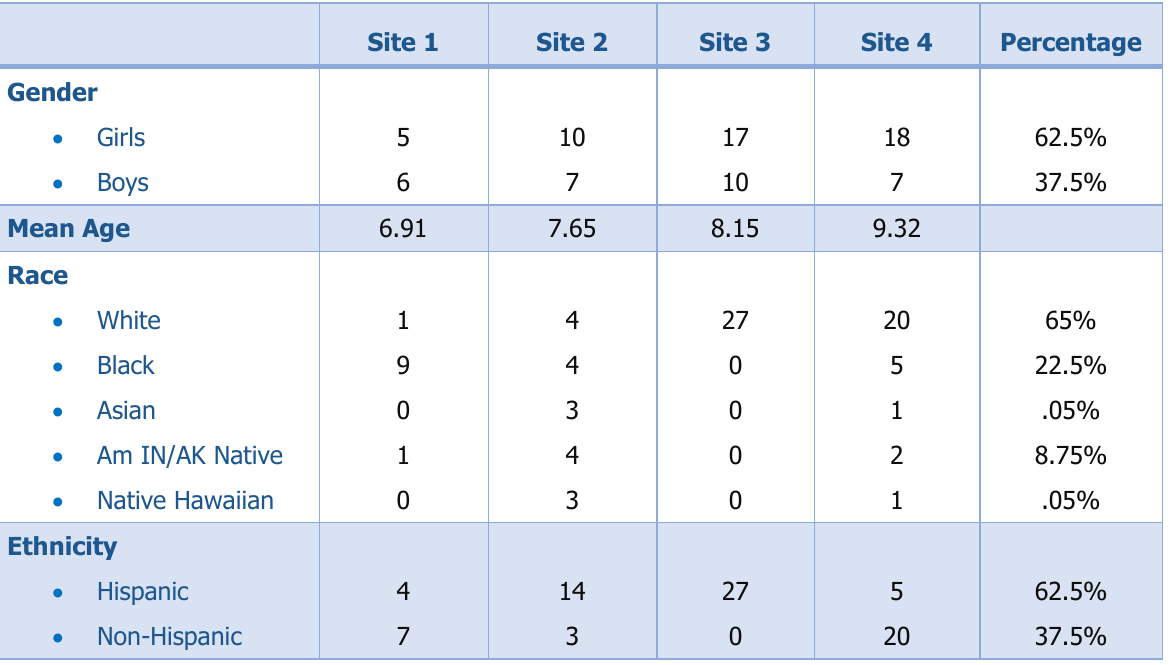
Table 2. Participant